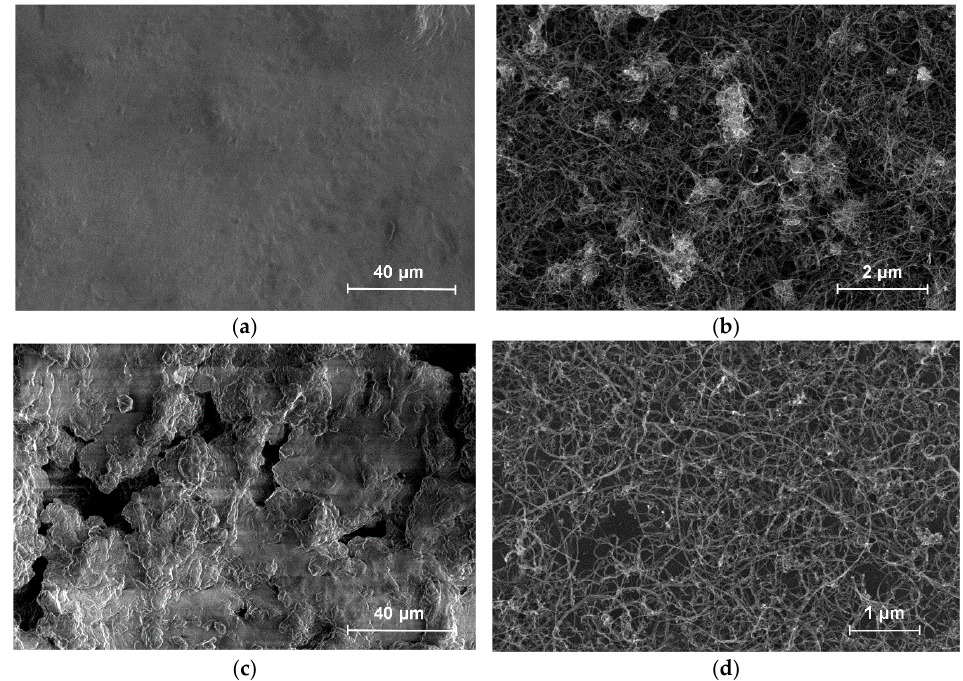
Figure 5. SEM of a strain-sensitive material without laser structuring: ( a ) Surface with ×2400 mag- nification; ( b ) internal structure of the MWCNT electrically conductive network with ×80,000 mag- nification. SEM of a strain-sensitive material after laser structuring; ( c ) surface with ×2400 magnifi- cation; ( d ) internal structure of the MWCNT electrically conductive network with ×60,000 magnifi- cation.